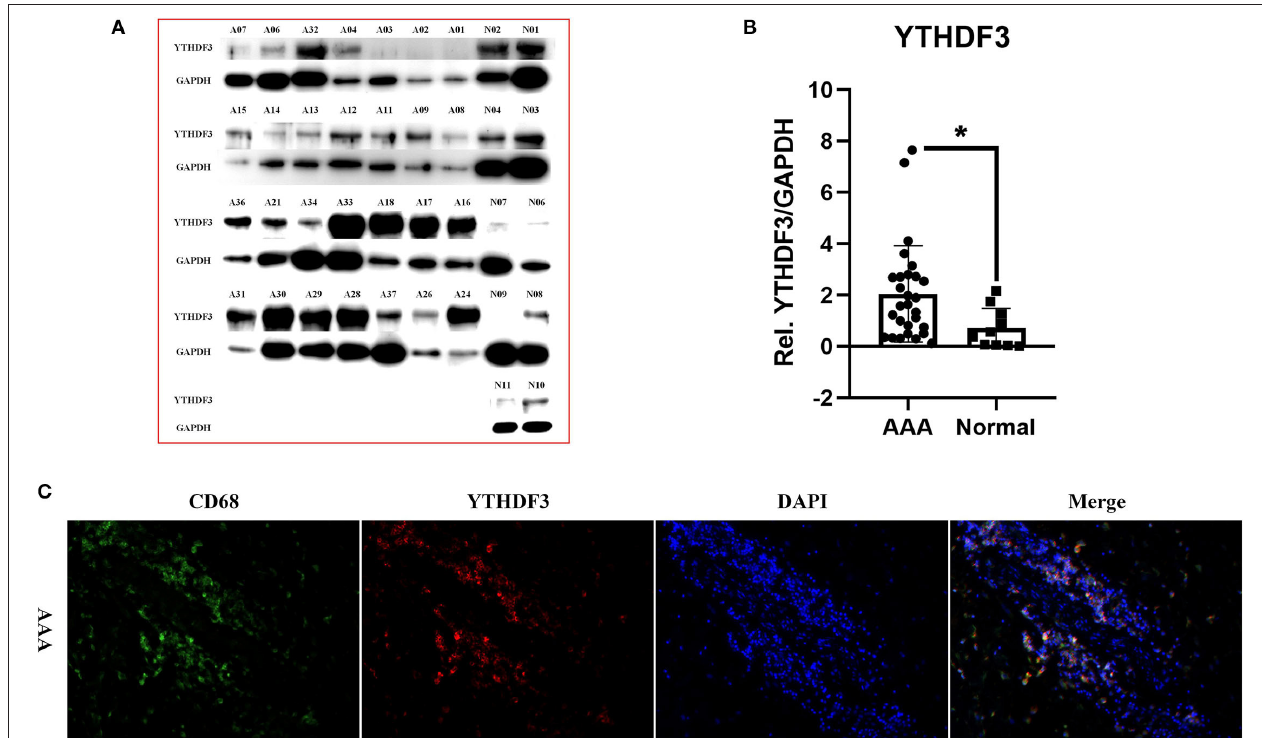
FIGURE 6 | The expression of YTHDF3 at protein level and its cellular localization in AAA tissues. (A) The images of Western Blot staining for YTHDF3 and GAPDH in each sample; (B) The box plot showing the relative expression of YTHDF3 (normalized to the signal intensity of GAPDH ) in AAA and normal aortic samples; (C) The photographs of immunofluorescence for human AAA sections stained with CD68 , YTHDF3 and 4’, 6-diamidino-2-phenylindole (DAPI). * P <